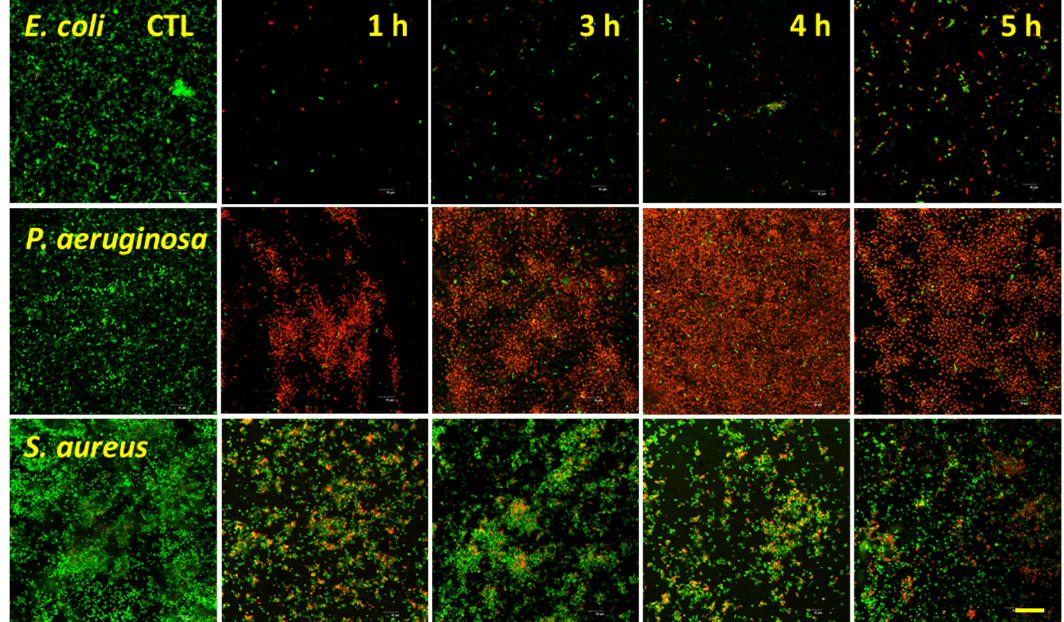
Figure 6. Confocal microscopy images of E. coli , P. aeruginosa , and S. aureus incubated on the surfaces of the titanium etched using 1 M KOH for 1, 3, 4, and 5 h. Bacteria were inoculated on the etched samples at a concentration of 10 6 CFUs and incubated for 20 h. Cells were stained with a LIVE/DEAD BacLight™ bacterial viability kit. Scale bar represents 20 µm.